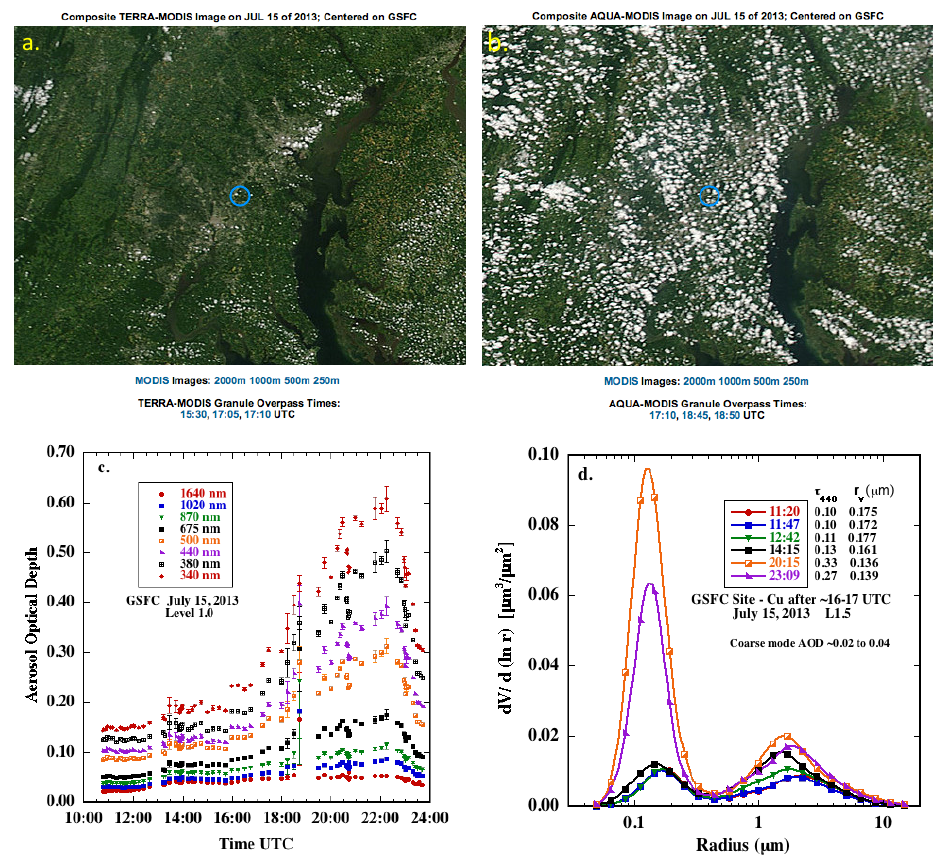
Figure 7. Both Terra and Aqua MODIS images (a) and (b) centered on the GSFC site (blue circle) on 15 July 2013. The spectral AOD time series from this day (c) and the volume size distribution retrievals (d) from before, during and after cumulus cloud formation are